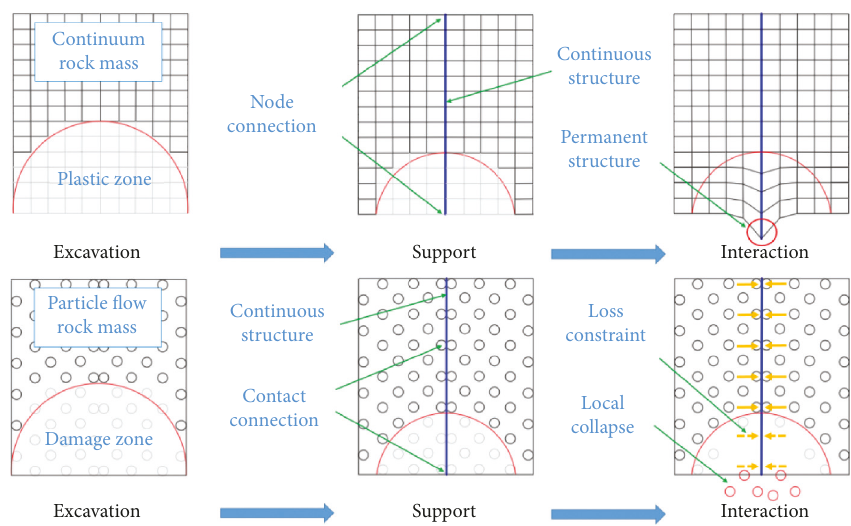
Figure 20: Interaction between support structural and rock